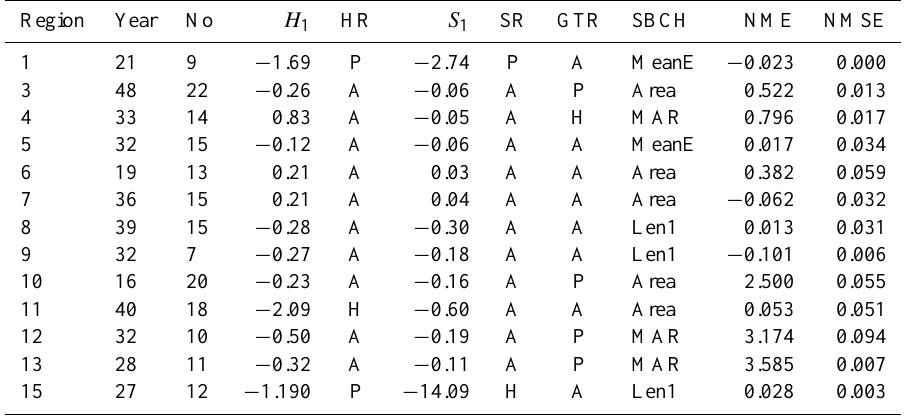
Table 2. The average record length, the number of gauged catchments, regional homogeneity test results, catchment characteristics used in the regression for the MAF, the NME in estimating the MAF and the NMSE of the CV of the AMF per region. Region Year No H